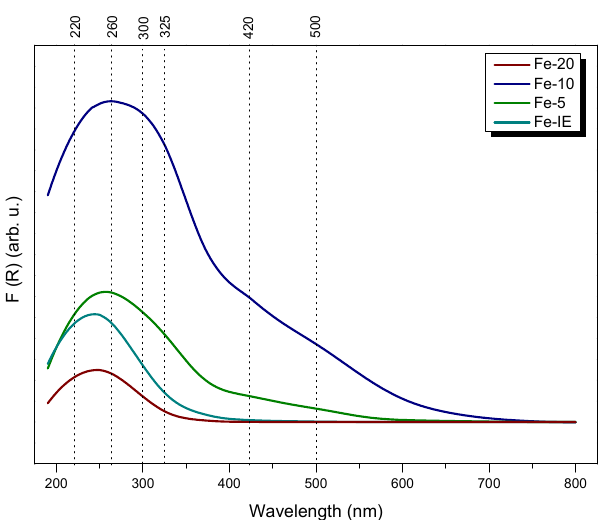
Figure 11. UV-vis spectra obtained for the catalysts.